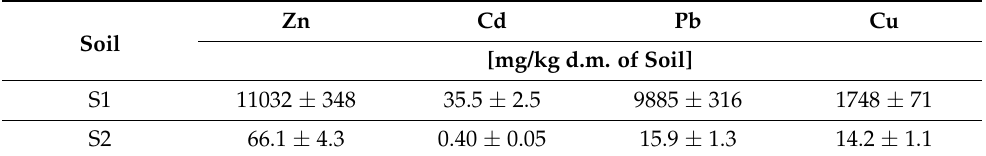
Table 2. Total metal concentration in soils G1 and G2 before pot experiment settlement. Zn Cd Pb Cu Soil [mg/kg d.m. of Soil] S1 11032 ± 348 35.5 ±